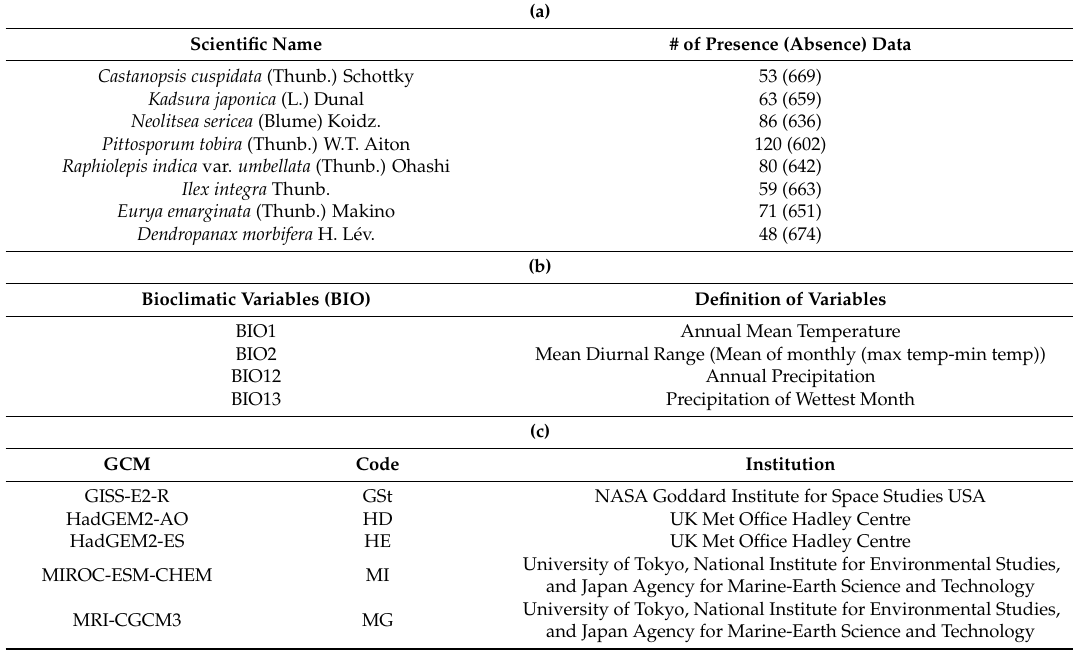
Table 1. Study species and model variables used for species distribution model (SDM) modeling and future predictions: Eight coastal warm-adapted evergreen broadleaved plants ( a ), five bioclimatic variables ( b ), and five global circulation models ( c